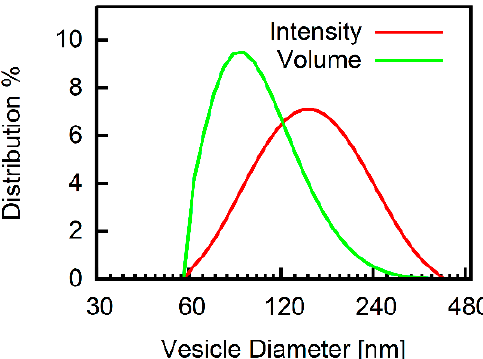
Figure 2. Vesicle size. Representative semi-logarithmic intensity and volume distributions (107.4 ± 38.4 nm) from Dynamic Light Scattering (DLS) measurements. 1,2-dioleoyl- sn -glycero-3-phosphocholine (DOPC) vesicles (100 mM KCl, 0.5 mM carboxyfluorescein (CF), 5 mM MES pH 7) after extrusion through a 100 nm filter and removal of external CF.